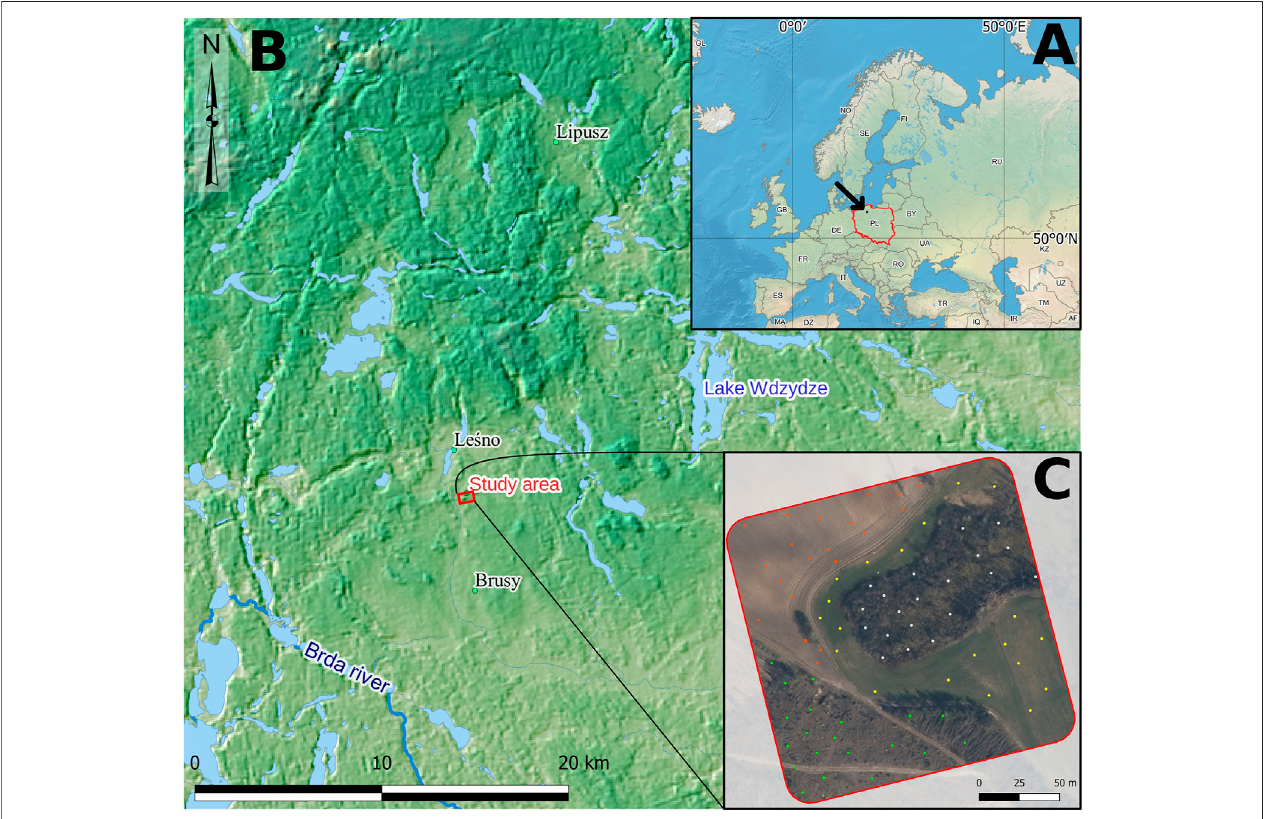
FIGURE 1 | Location of the study area [prepared based on: (A) — Poland, (B) — Digital Elevation Model of location, (C) — boundaries of the working area and sampling points (GUGiK, 2020)]; Data, equipment and software.